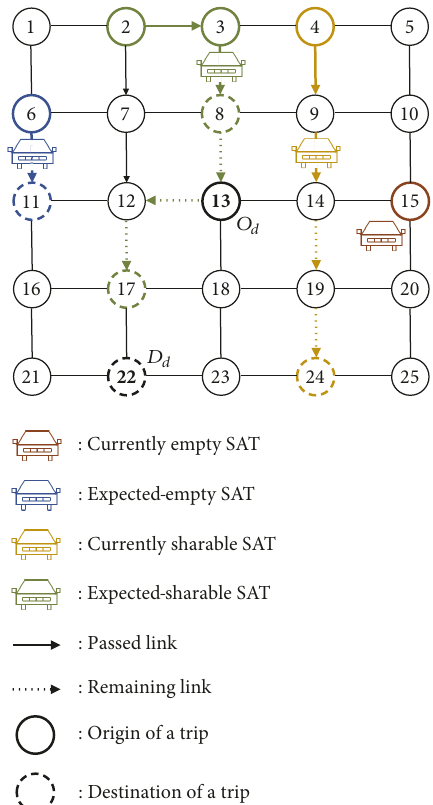
Figure 2: Four types of available